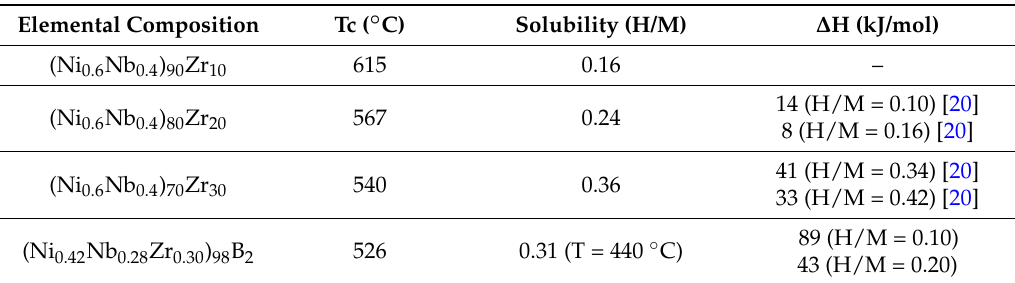
Table 3. Elemental composition, crystallization temperature T C (defined as the maximum of the first peak in DTA measurements conducted with a temperature rate of 10 ◦ C/min), solubility at T = 400 ◦ C and p = 7 bar and dehydrogenation enthalpy of the investigated